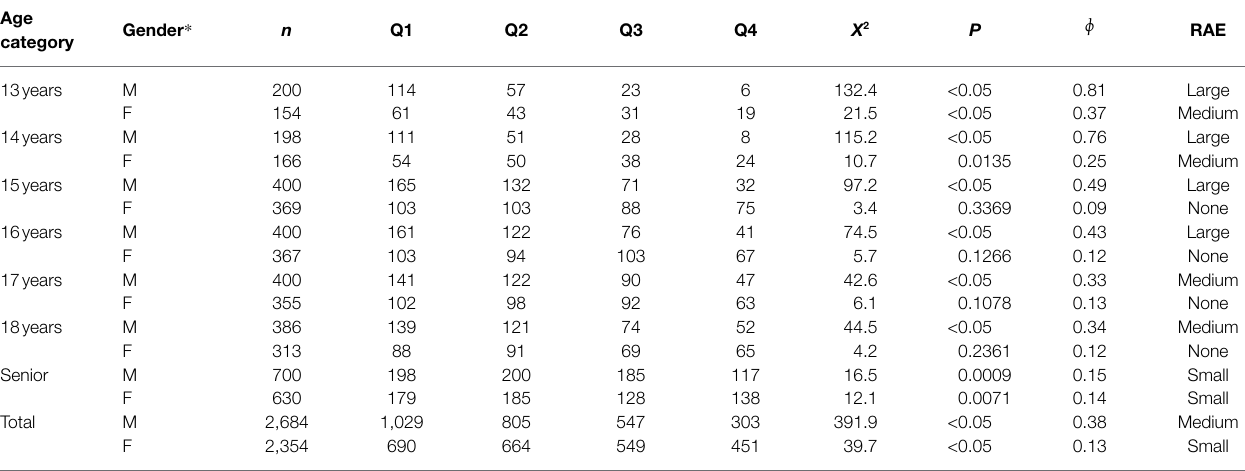
TABLE 3 | Prevalence of RAE in the endurance events among the all time best Norwegian track and field athletes, by age and gender. Age Gender * n Q1 category